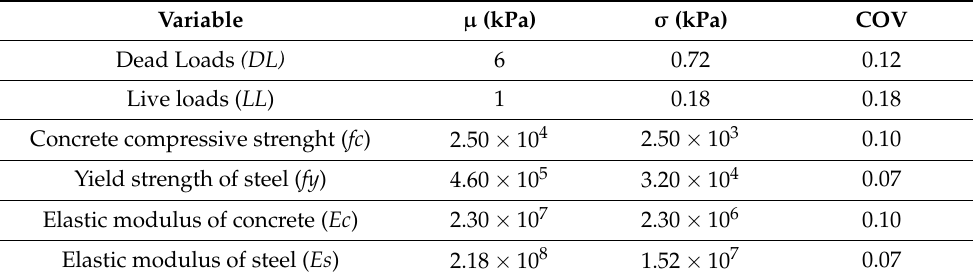
Table 1. Mean, standard deviation and coefficient of variation of the random variables.